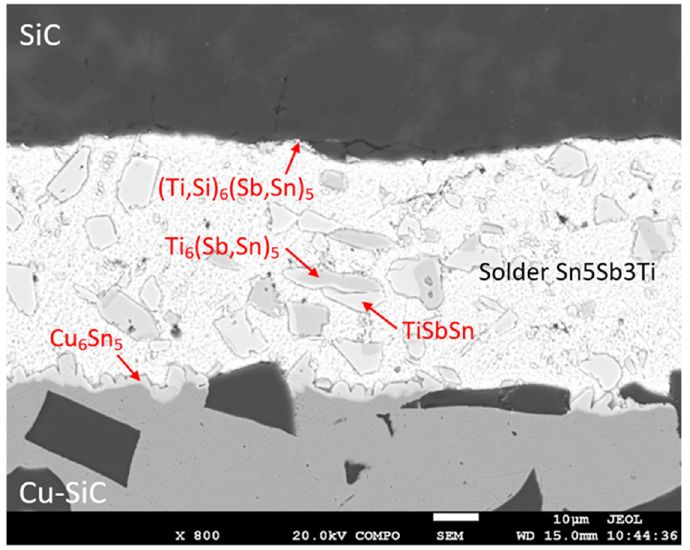
Figure 16 . Microstructure of the SiC/Sn5Sb3Ti/Cu–SiC joint from the SEM analysis in BSE mode . Figure 16. Microstructure of the SiC/Sn5Sb3Ti/Cu–SiC joint from the SEM analysis in BSE